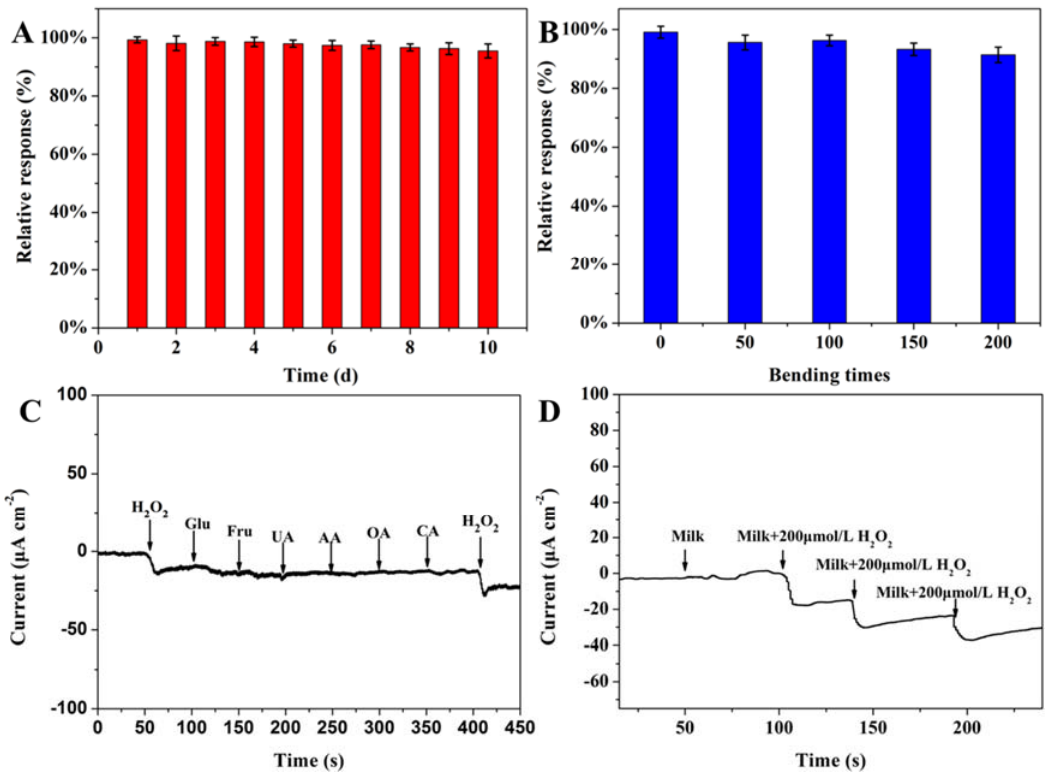
Figure 8. ( A ) Long ‐ term stability test of the Pt/rGOP. ( B ) Effects of bending times on the current response to 10 μ mol/L of H 2 O 2 of the flexible Pt/rGOP electrode. ( C ) Amperometric responses upon successive addition of 0.1 mmol/L H 2 O 2 , 0.2 mmol/L Glu, 0.2 mmol/L Fru, 0.2 mmol/L UA, 0.2 mmol/L AA, 0.2 mmol/L OA, 0.2 mmol/L CA and 0.1 mmol/L H 2 O 2 at − 0.25 V in 10 mL PBS. ( D ) Amperometric curve of successive addition of milk containing H 2 O 2 in 0.1 mol/L PBS.